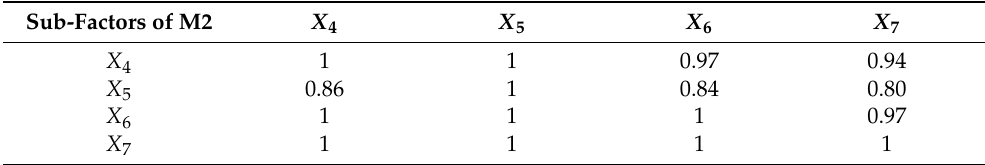
Table 9. Judgment matrix of the sub-factor layer to the upper factor M 2 .